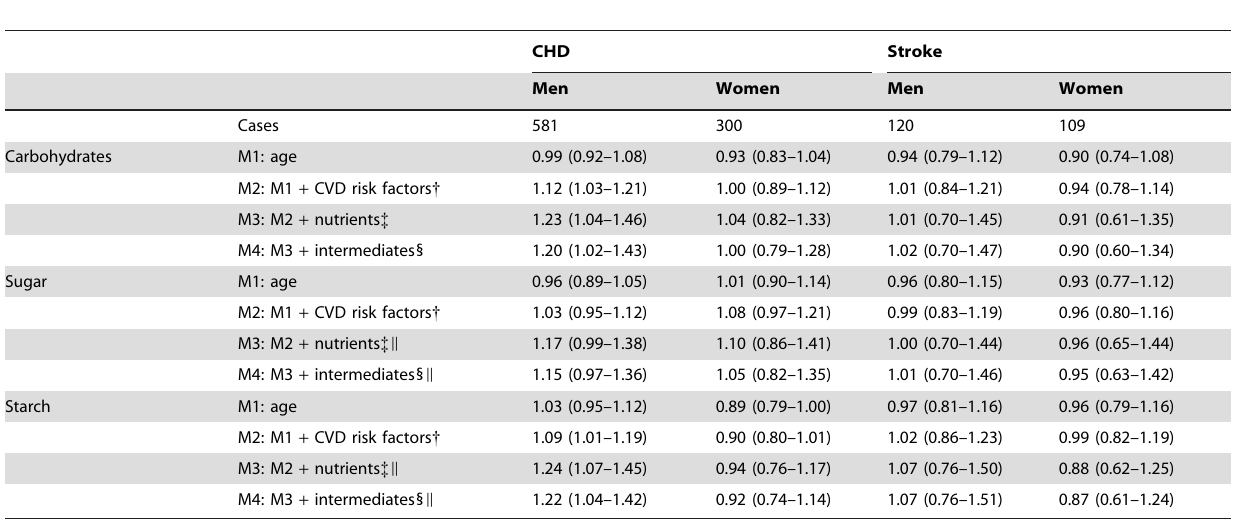
Table 3. Total Carbohydrate, Sugar, and Starch, and the Risks of Coronary Heart Disease and Stroke Among 8,855 Men and 10,753